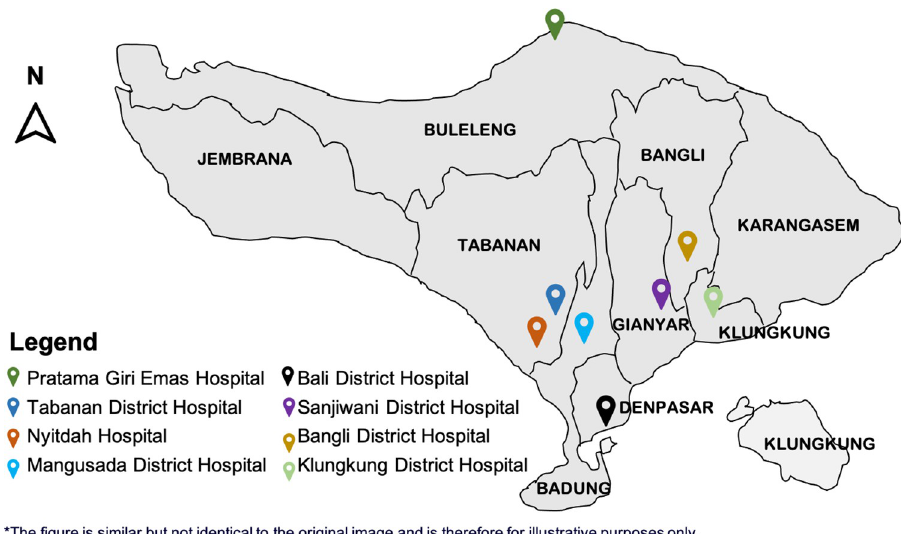
Fig 1. Plotted map of hospitals in Bali where patients